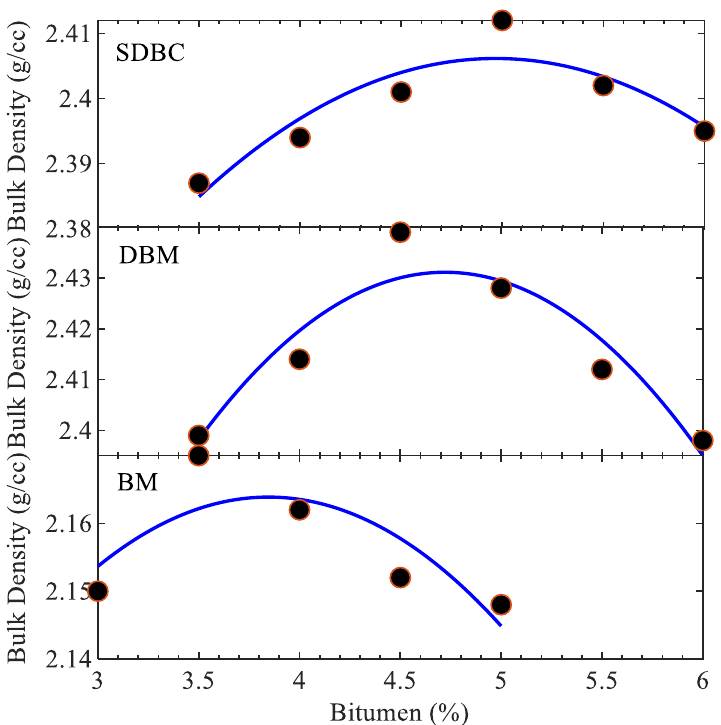
Fig. 8 Relations between bulk density with bitumen content for SDBC, DBM, and